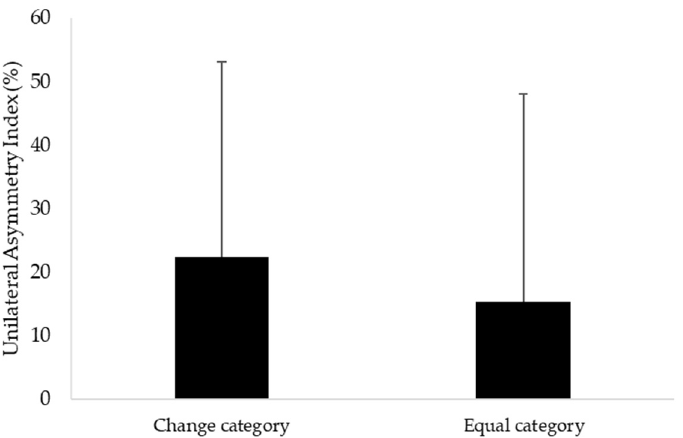
Figure 4. Means and standard deviations of Unilateral Asymmetry Index between the Bilateral Asymmetry equal and change categories.